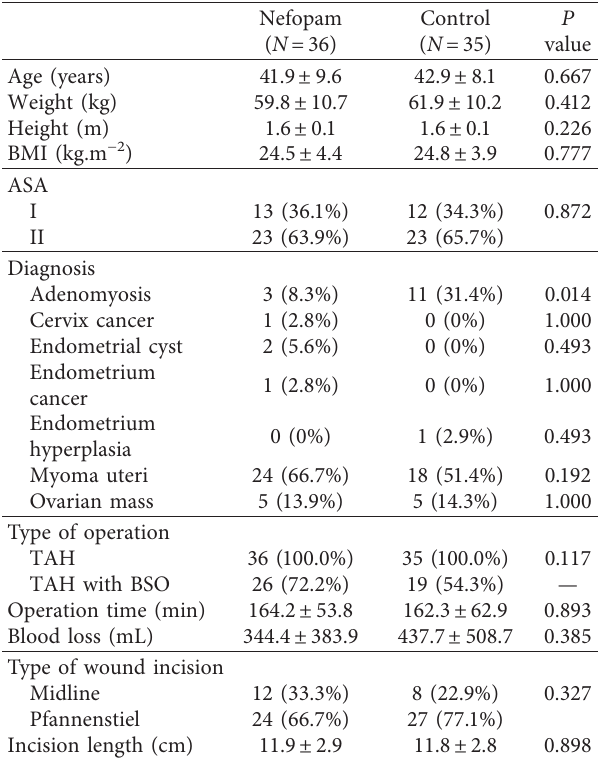
Table 1: Demographic